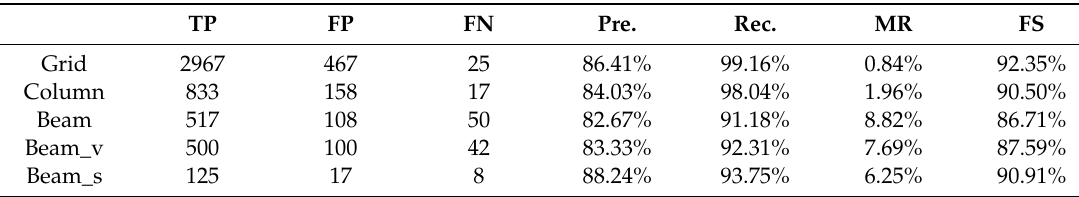
Table 4. Detection performance for di ff erent objects in test